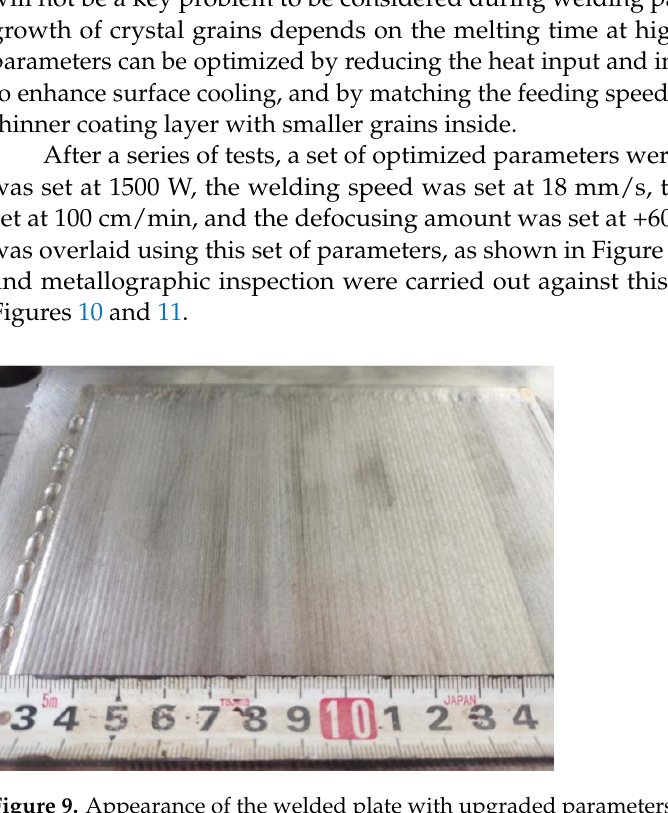
Table 7. Welding parameters to survive the welding processes.